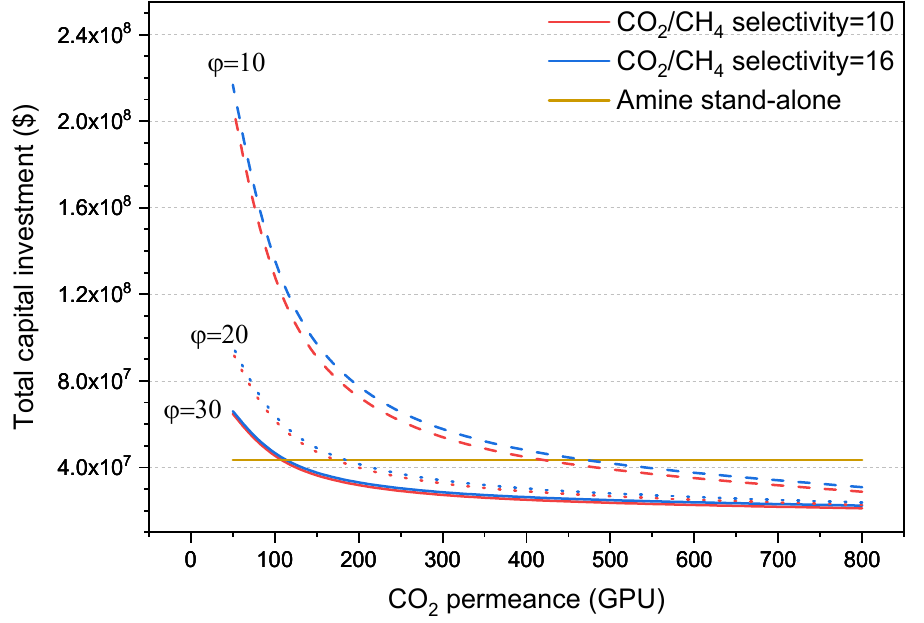
Figure 4. Effect of CO 2 permeance on the TCI of the hybrid process at CO 2 /CH 4 selectivity of 10 (red lines) and 16 (blue lines) and different pressure ratios of 10 (dash lines), 20 (dot lines), and 30 (solid lines). The cost is compared to the cost of the stand-alone amine process (horizontal dark yellow line).